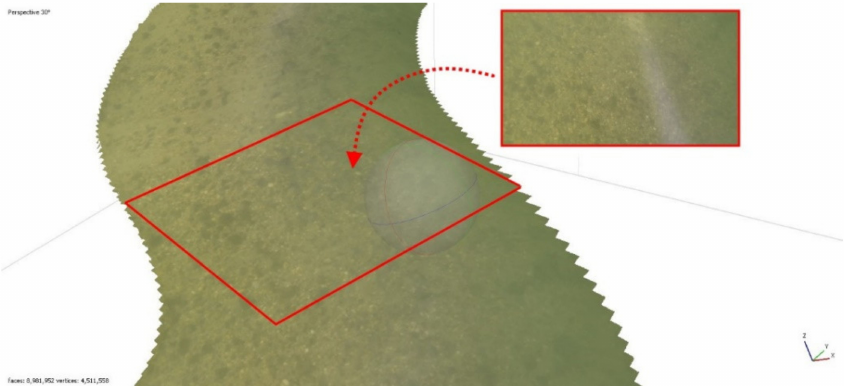
Figure 12. The applied Structure-from-Motion (SfM)-Multiview method analyzed and patched together the frame images of the video. The location and placement of one image can be seen in the figure, along with the modeled surface along the camera